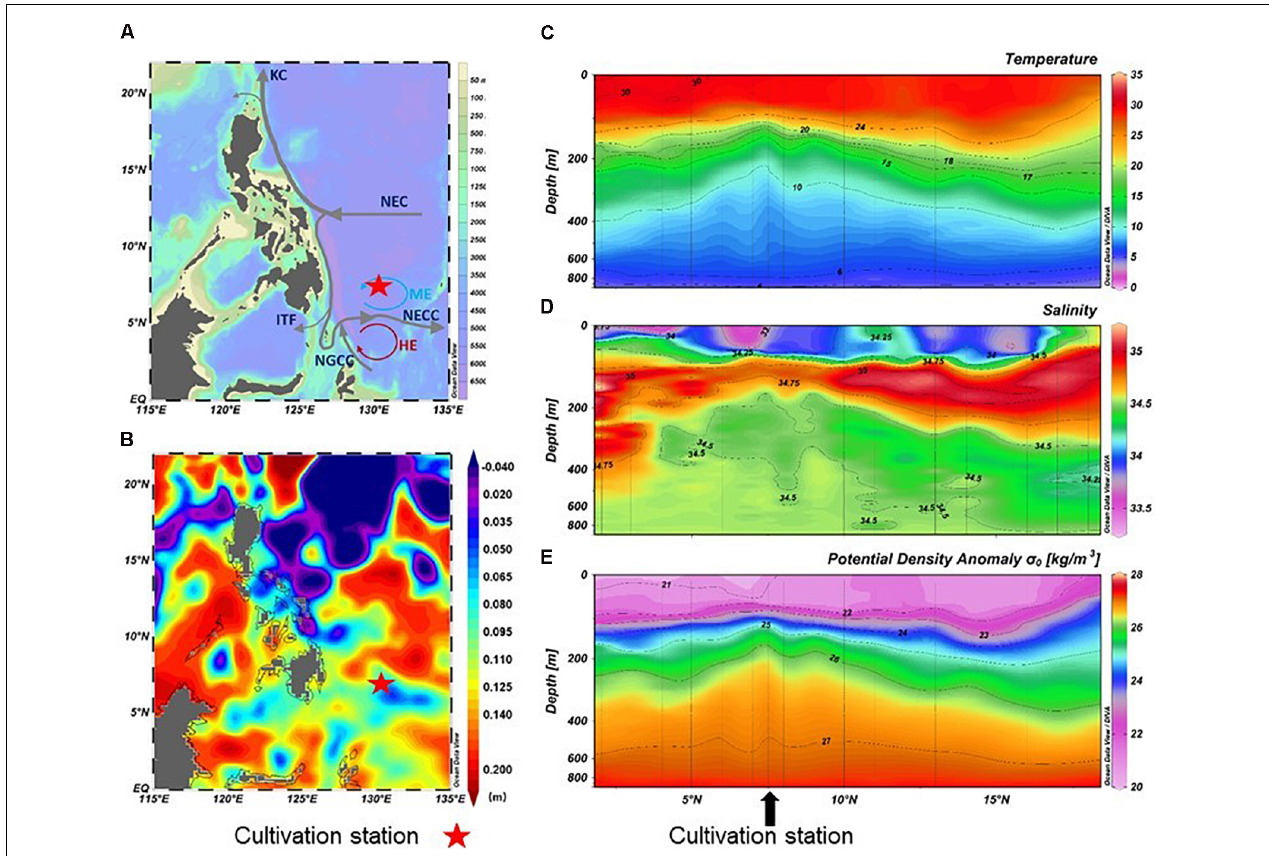
FIGURE 1 | Map showing the sampling station (A) , sea surface height (B) , and distribution of temperature (C) , salinity (D) , and potential density anomaly σ t (E) in the upper 1000 m. KC, Kuroshio Current; NEC, North Equatorial Current; NECC, North Equatorial Countercurrent; ITF, Indonesian throughflow; NGCC, New Guinea Coastal Current; ME, Mindanao Eddy; HE, Halmahera Eddy. Dataset of sea surface height was downloaded from Archiving Validation and Interpolation of Satellite Oceanographic Data, AVISO; http://www.aviso.altimetry.fr/